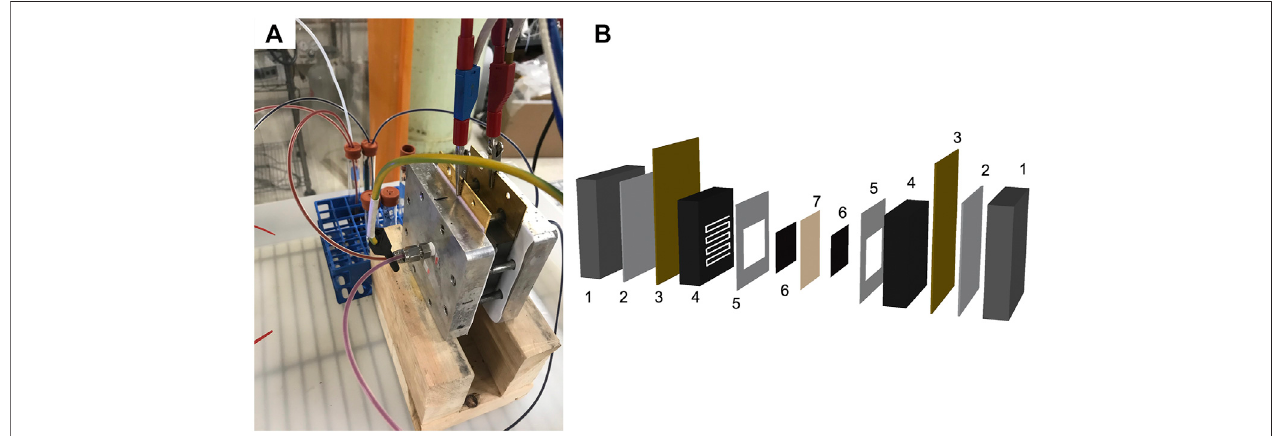
FIGURE 3 | Redox fl ow battery (A) photo and (B) exploded diagram of the cell. The cell components are (1) metal plates, (2) polytetra fl uoroethylene (PTFE) insulating layers, (3) gold coated current collectors, (4) poco graphite bipolar plates with serpentine fl ow fi elds, (5) PTFE gaskets, (6) porous carbon electrodes, and (7) a